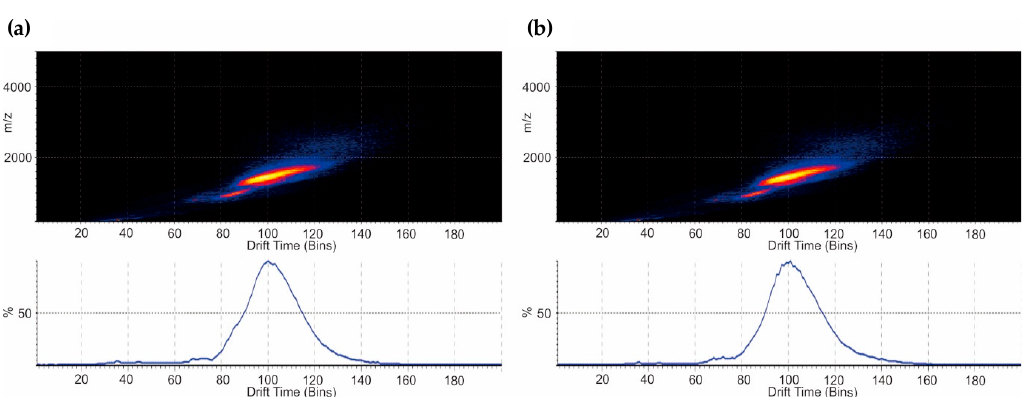
Figure 7. ( a ) The drift time generated from traveling wave IMS after IM-MS analysis under denaturing conditions for NovoSeven ® ; and ( b ) AryoSeven™ displayed homogenous driftscope plots between 60 and 140 Bins.